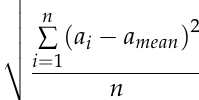
7 of 17 Figure 4. Stress nephogram of finite element simulation of “machine-pavement” system during jumping. 2.3. Methods for Determining Statistical Indicators To select appropriate indicators to evaluate the stability of the vibratory system and